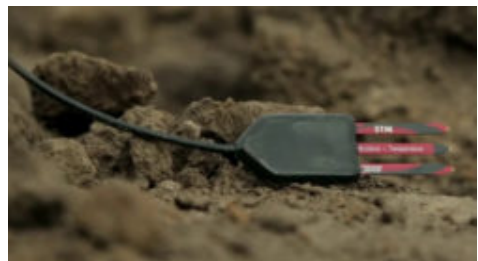
Figure 2. Decagon 5TM to measure underground soil moisture (https://www.ictinternational.com/products/5tm/decagon-5tm-